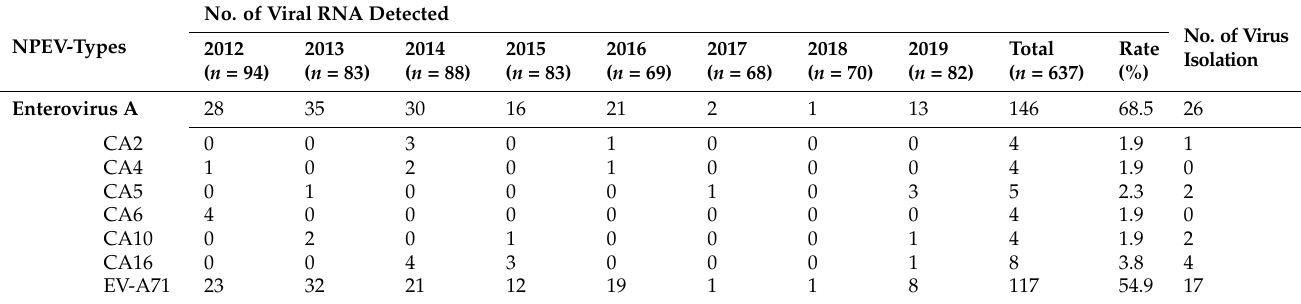
Table 4. Distribution of NPEV genotypes of AFP surveillance in Korea,